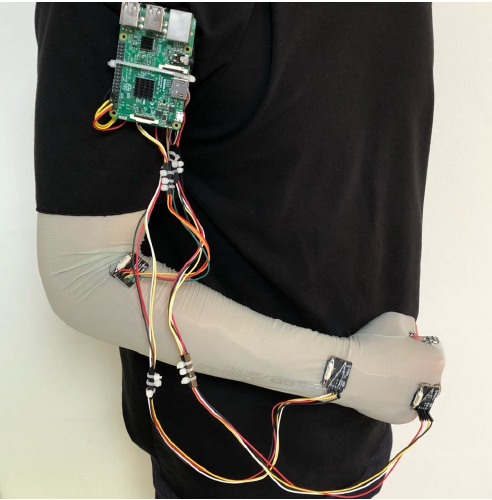
Figure 1. Data collection unit set up.